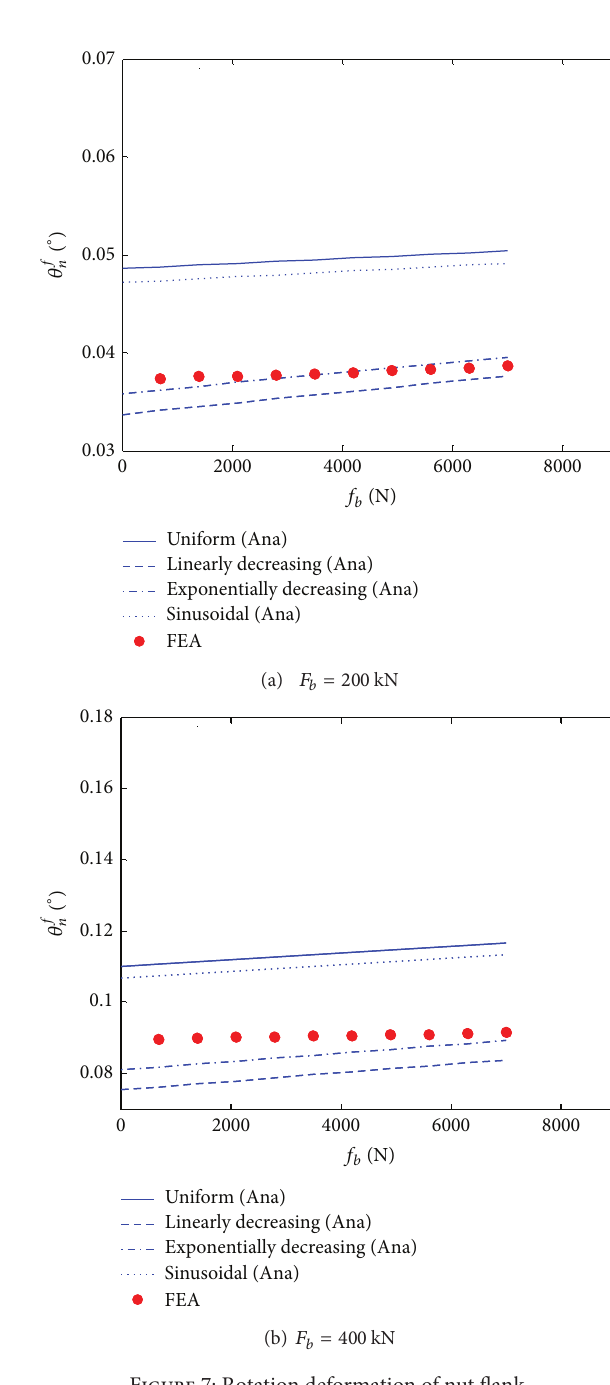
Figure 7: Rotation deformation of nut